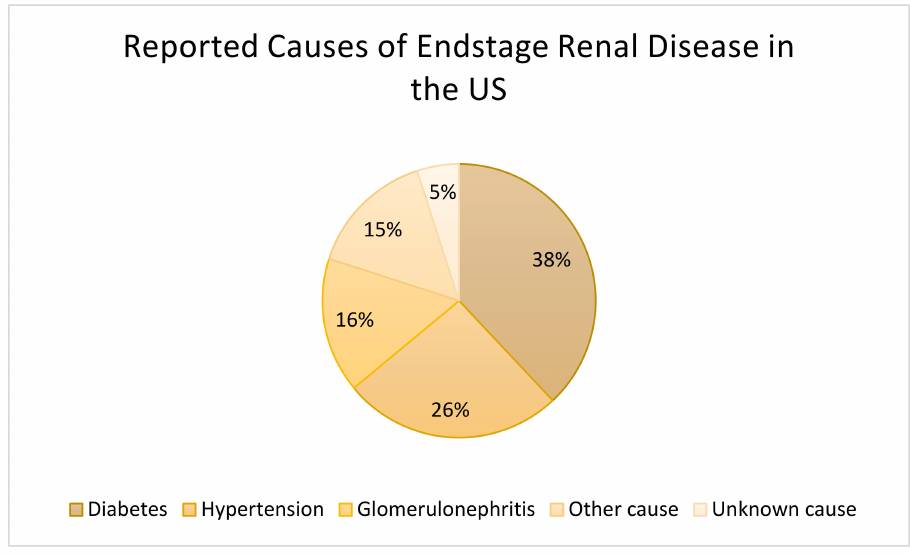
Figure 1. Causes of End-Stage Kidney Disease in the United States in 2016. Data based on patients of all ages (n = 726,331)